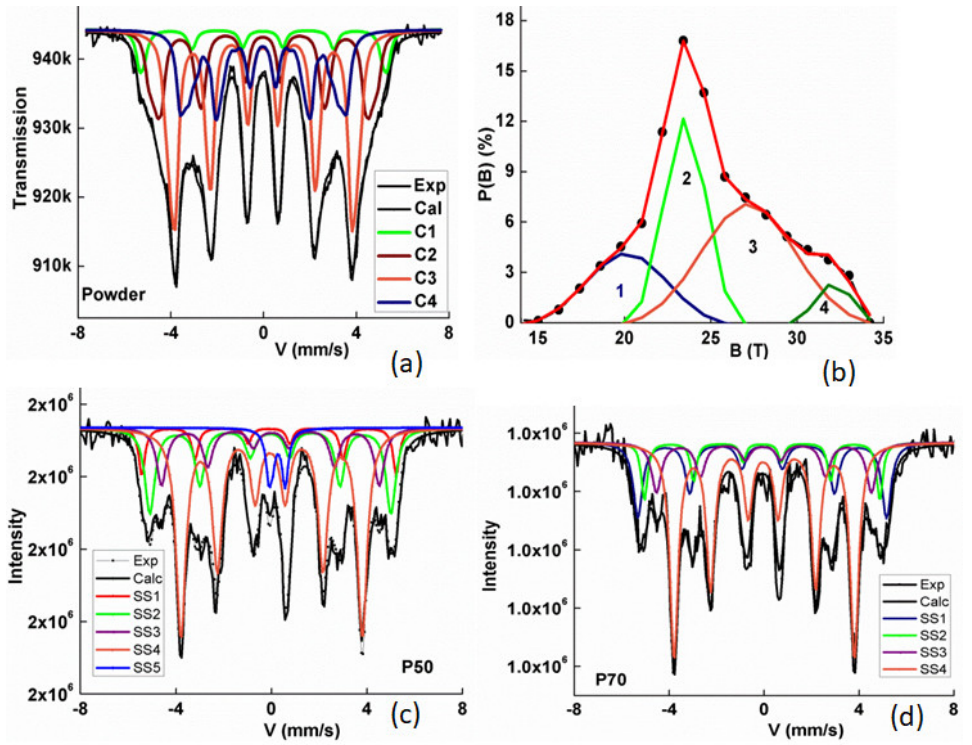
Figure 5. Mössbauer spectrum of the feedstock powder ( a ) and corresponding HFD ( b ) and Möss- bauer spectra of the laser melted samples P50 ( c ) and P70 ( d ). Table 4. Hyperfine parameters (hyperfine field, B hf (T), isomer shift, IS (mm/s) , quadrupolar shift, 2 ε (mm/s), quadrupolar splitting, ∆ (mm/s), linewidth at half height, Γ (mm/s), area ( % ), average hyperfine field, < B hf >, and average isomer shift, < IS >, of the raw powder, P50 and P70 samples.